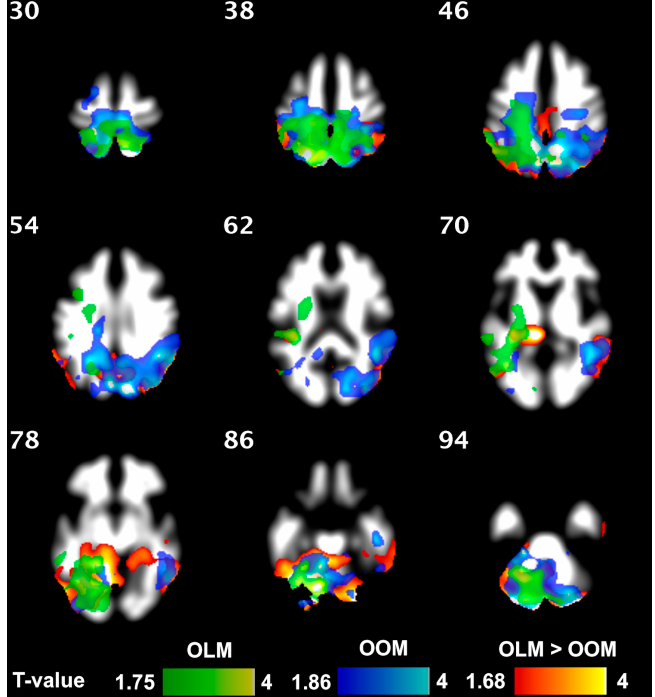
Figure 3. Exercise increased WM density both in OLM ( green ) and OOM ( blue ). The two color scales represent the t -values of the statistical test. The lowest visualized t -value in the color scales corresponds to p = 0.05. The brain areas where the exercise vs. group interaction resulted in significant effects are highlighted in orange . Within these areas, the OLM group exhibited greater increases in WM density than the OOM group following 4 months of training.